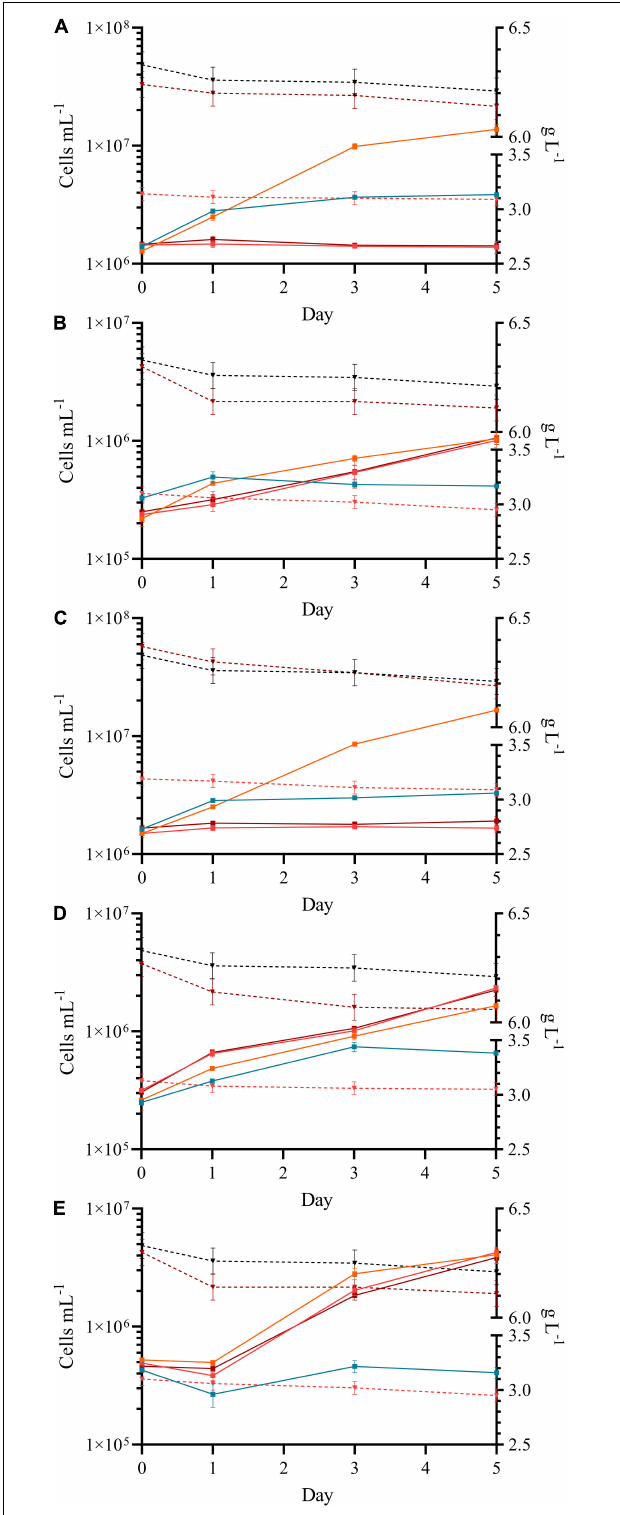
FIGURE 5 | Growth curves of Chlorella vulgaris (13–1) (A) , Chlorococcum sp. (MC-1) (B) , Coelastrella sp. (3–4) (C) , Desmodesmus sp. (2–6) (D) and